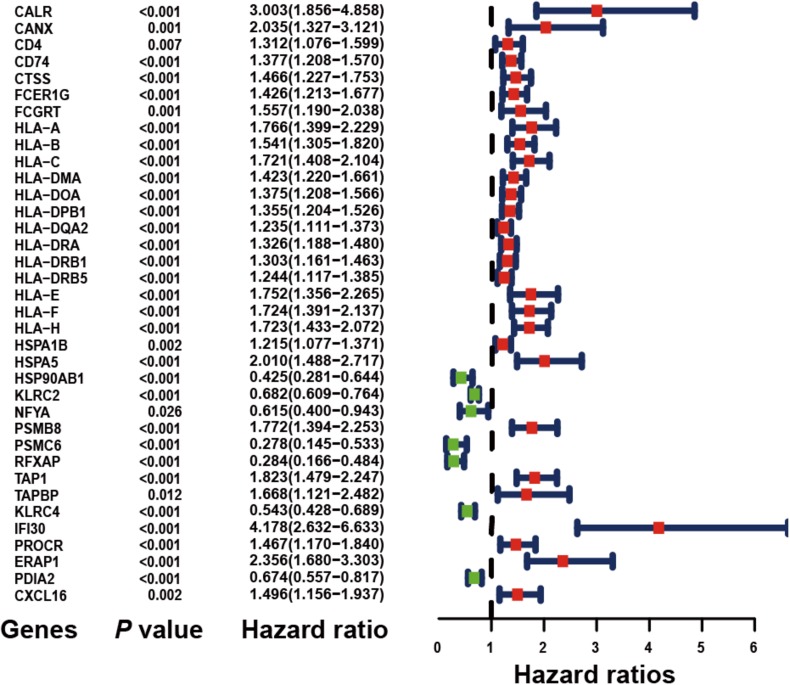
Forest plot of hazard ratios demonstrating the prognostic values of immune-related genes (IRGs). The dash line was used to mark the location of HR = 1. The red box represents the adverse prognostic factor; Blue box represents the favorable prognostic factor.